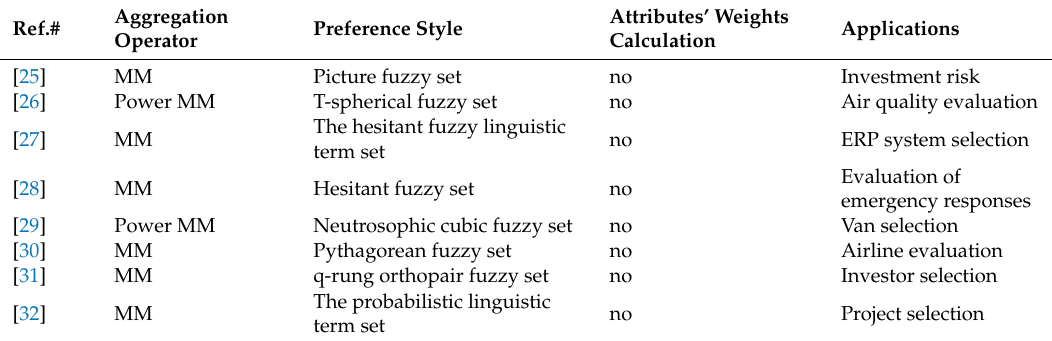
Table 1. Review of MM operator on di ff erent fuzzy